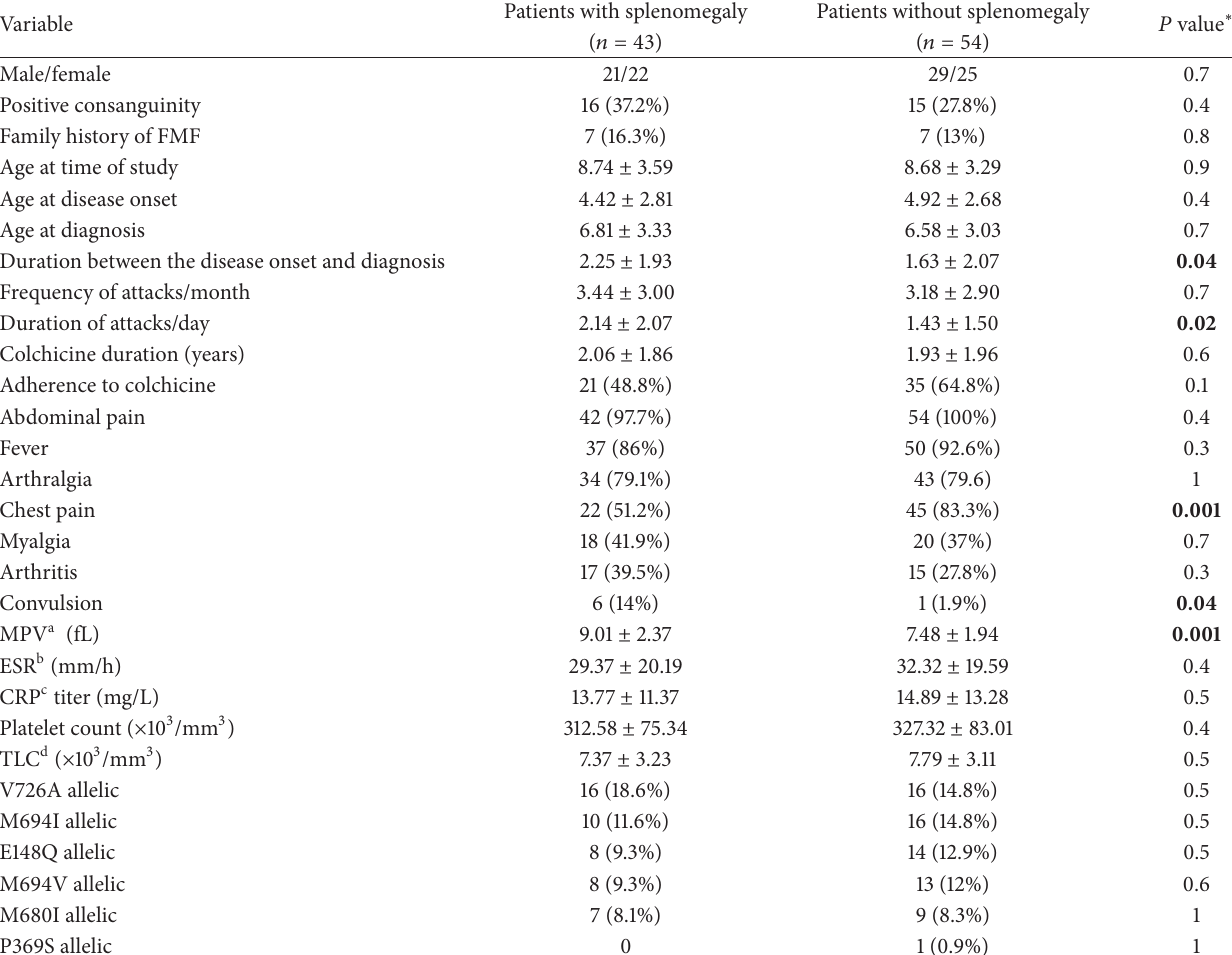
Table 2: Characteristics, clinical findings, and laboratory investigations of FMF patients stratified by the presence of splenomegaly ( 𝑛 = 97 ).